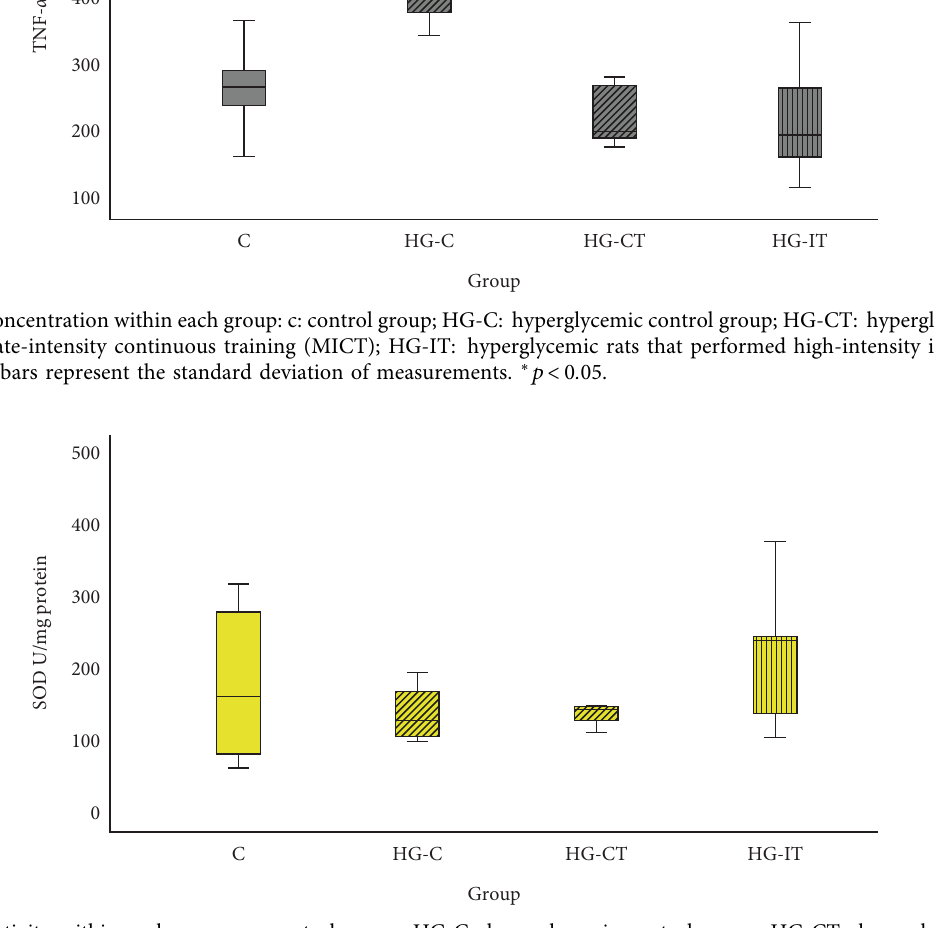
Figure 5: SOD activity within each group. c: control group; HG-C: hyperglycemic control group; HG-CT: hyperglycemic rats that performed moderate-intensity continuous training (MICT); HG-IT: hyperglycemic rats that performed high-intensity interval training (HIIT). Te error bars represent the standard deviation of